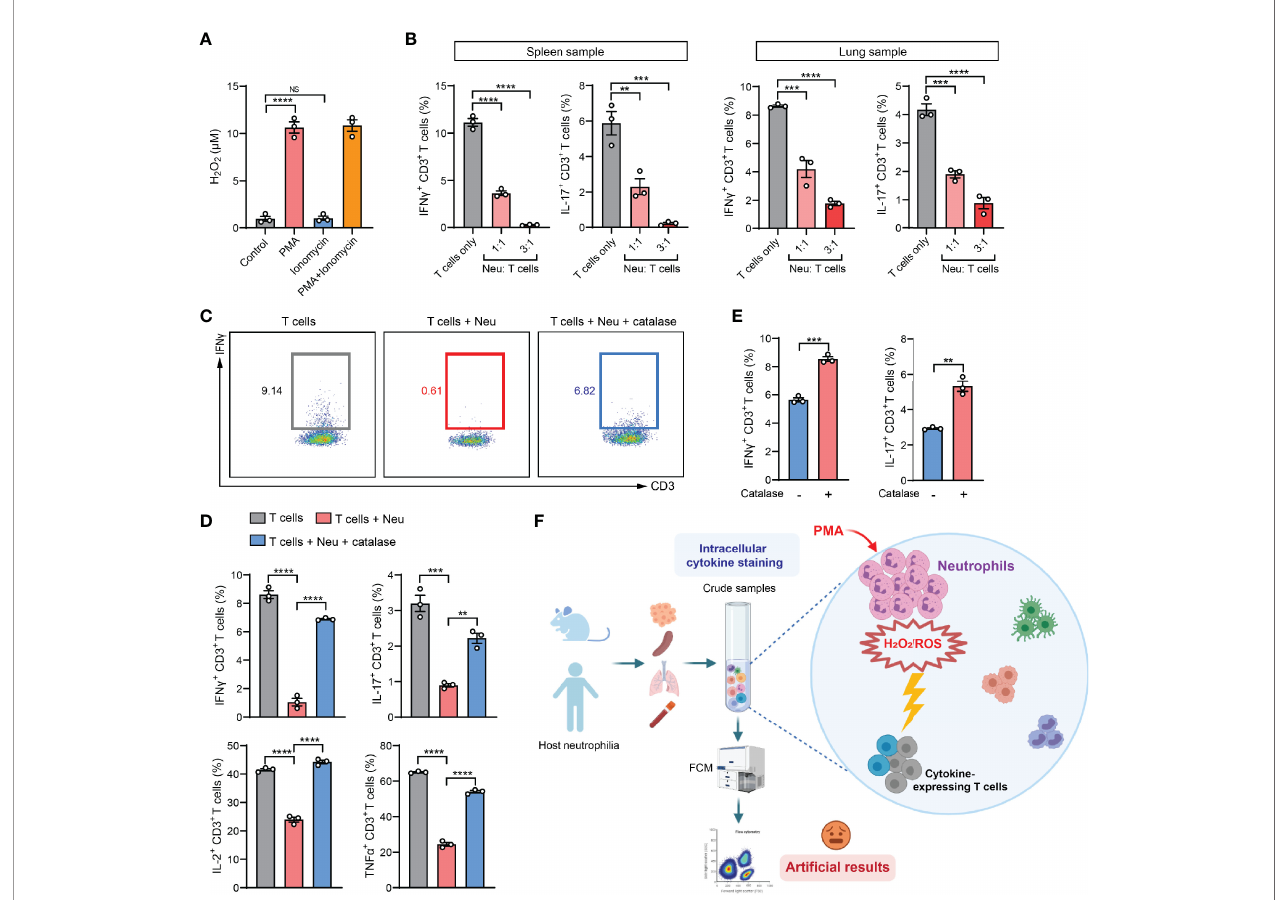
FIGURE 5 | The ICS-associated artifact occurs in human immune cell analyses. (A) H 2 O 2 levels in human neutrophils isolated from lung tissues of MDA-MB-231 tumor-bearing Hu-CD34 + mice (n=3) were measured after incubation with PMA (25 ng/ml) or ionomycin (1 µg/ml) or co-treatment with PMA (25 ng/ml) + ionomycin (1 µg/ml) for 30 minutes at room temperature. (B) Human T cells and neutrophils were isolated from spleen or lung tissues of MDA-MB-231 tumor-bearing Hu- CD34 + mice (n=3), mixed together at the indicated ratios and then subjected to ICS analysis. The frequencies of IFN g + CD3 + T cells or IL-17 + CD3 + T cells were quanti fi ed. (C, D) Human T cells and neutrophils were isolated from lung tissues of MDA-MB-231 tumor-bearing Hu-CD34 + mice (n=3), mixed together in the absence or presence of catalase (1000 U/ml), and then subjected to ICS analysis. The frequencies of IFN g + CD3 + T cells, IL-17 + CD3 + T cells, IL-2 + CD3 + T cells and TNF a + CD3 + T cells were quanti fi ed. (E) Crude PB samples derived from MDA-MB-231 tumor-bearing Hu-CD34 + mice (n=3) were subjected to ICS analysis in the absence or presence of catalase (1000 U/ml). The frequencies of IFN g + CD3 + T cells and IL-17 + CD3 + T cells were quanti fi ed. (F) A proposed model: in crude